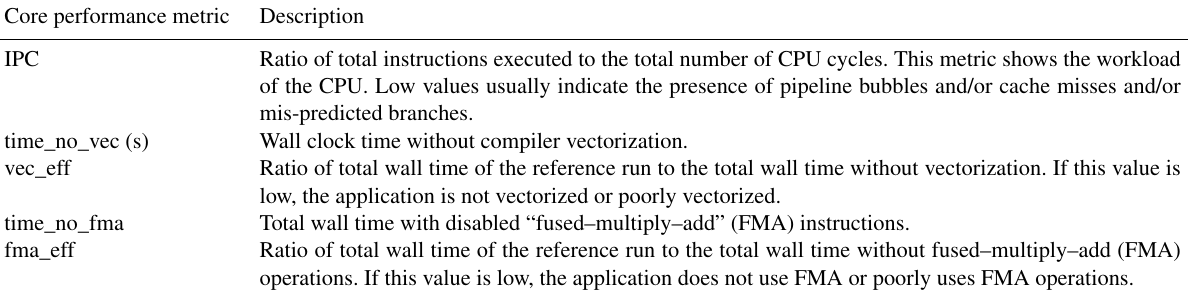
Table B6. Description of performance analysis metrics pertaining core-level performance currently supported by our RCF. Core performance metric